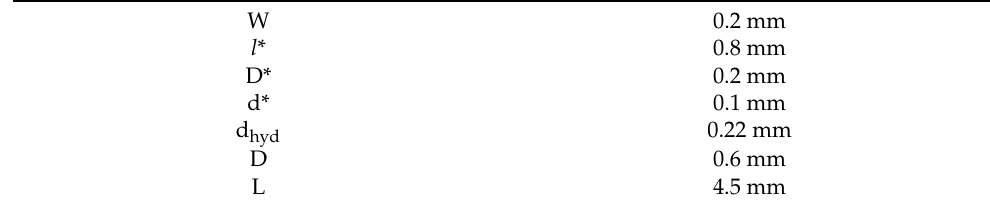
Figure 1. ( a ): 3-D view design of the proposed micromixers, ( b ): geometric parameters. Table 1. Dimensions information of the proposed micromixer.